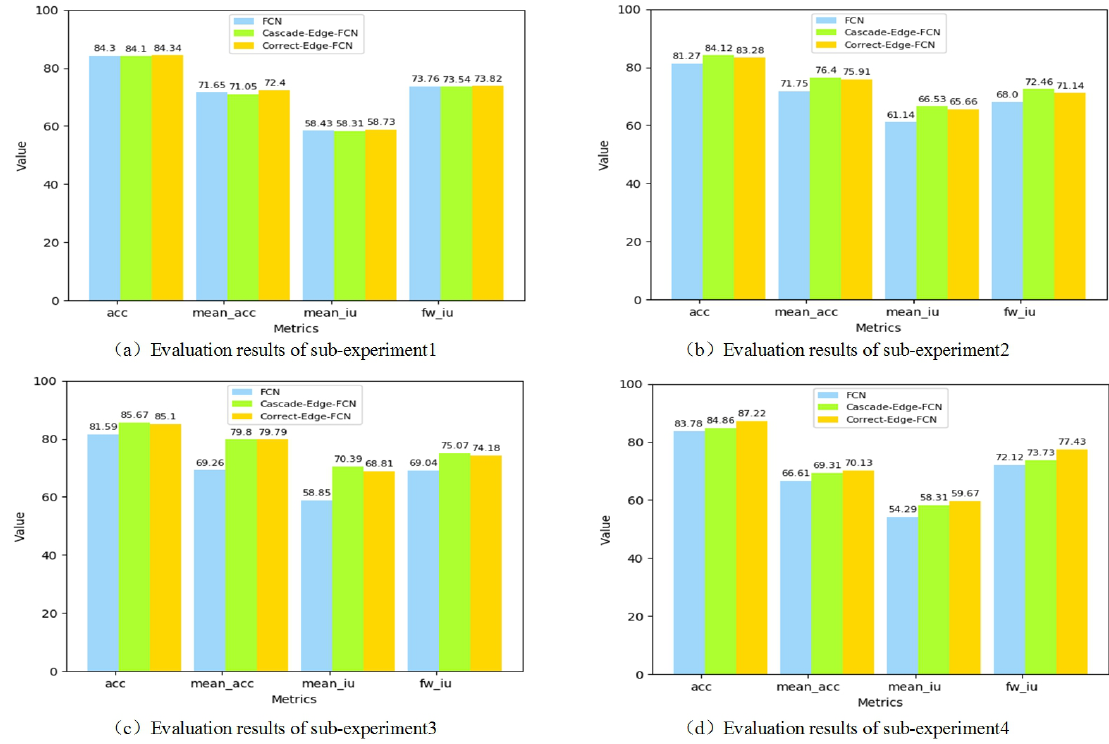
Figure 8. Evaluation results of four sub-experiments on ESAR dataset. It can be clearly seen from the height of the “bar” that our proposed algorithm performs better than